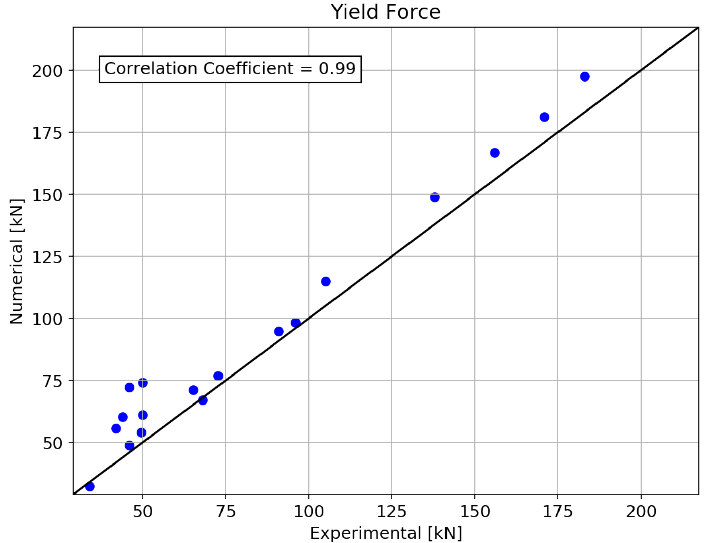
Figure 7. Comparison between numerical and experimental results regarding yield force.